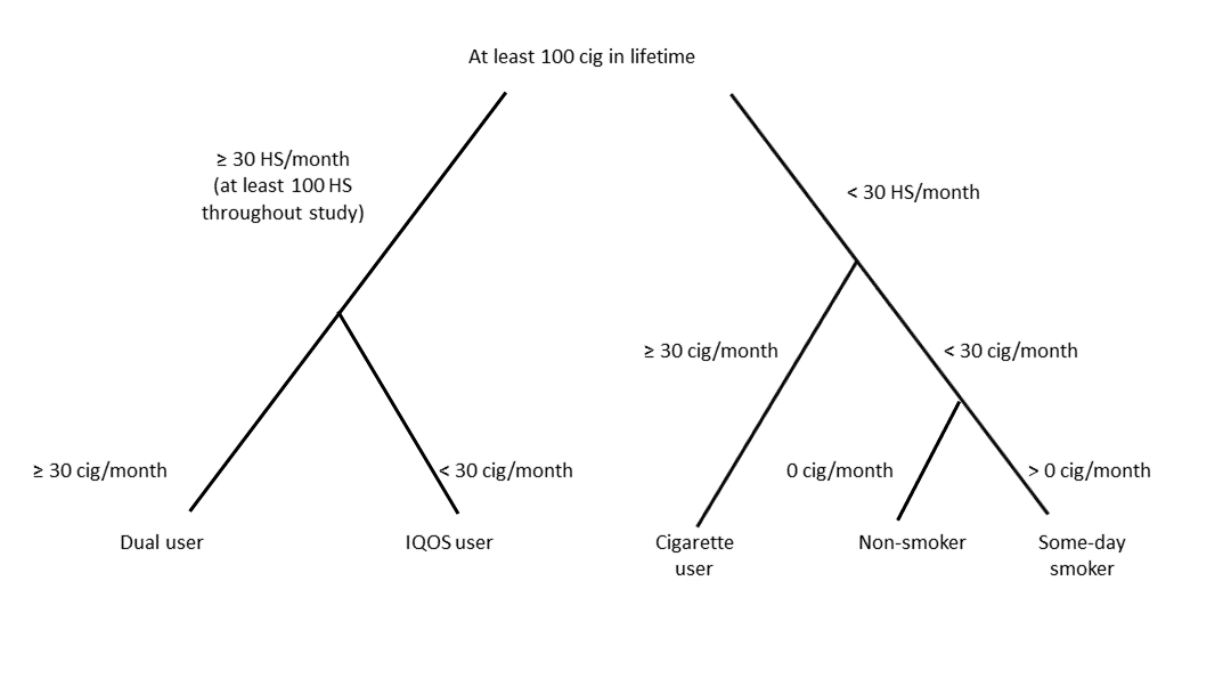
Figure 2. Product use classification tree. Cig: cigarette; HS: